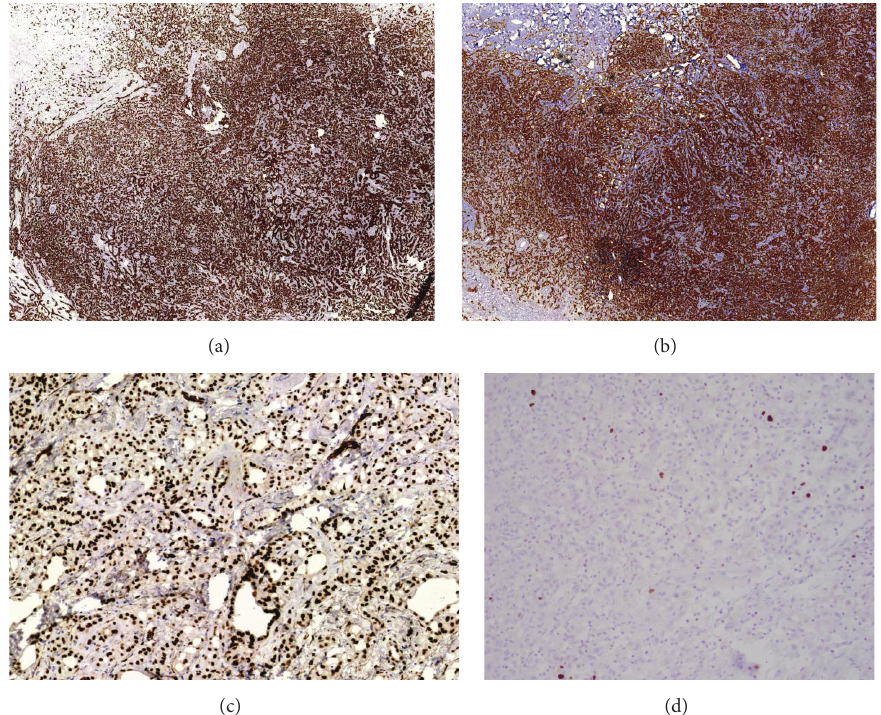
Figure 3: The mesothelial nature of the neoplasm was confirmed by its expression of pancytokeratin (a), calretinin (b), and nuclear WT1 (c). Ki-67 (d) showed a < 2% proliferation rate. A diagnosis of adenomatoid tumor was